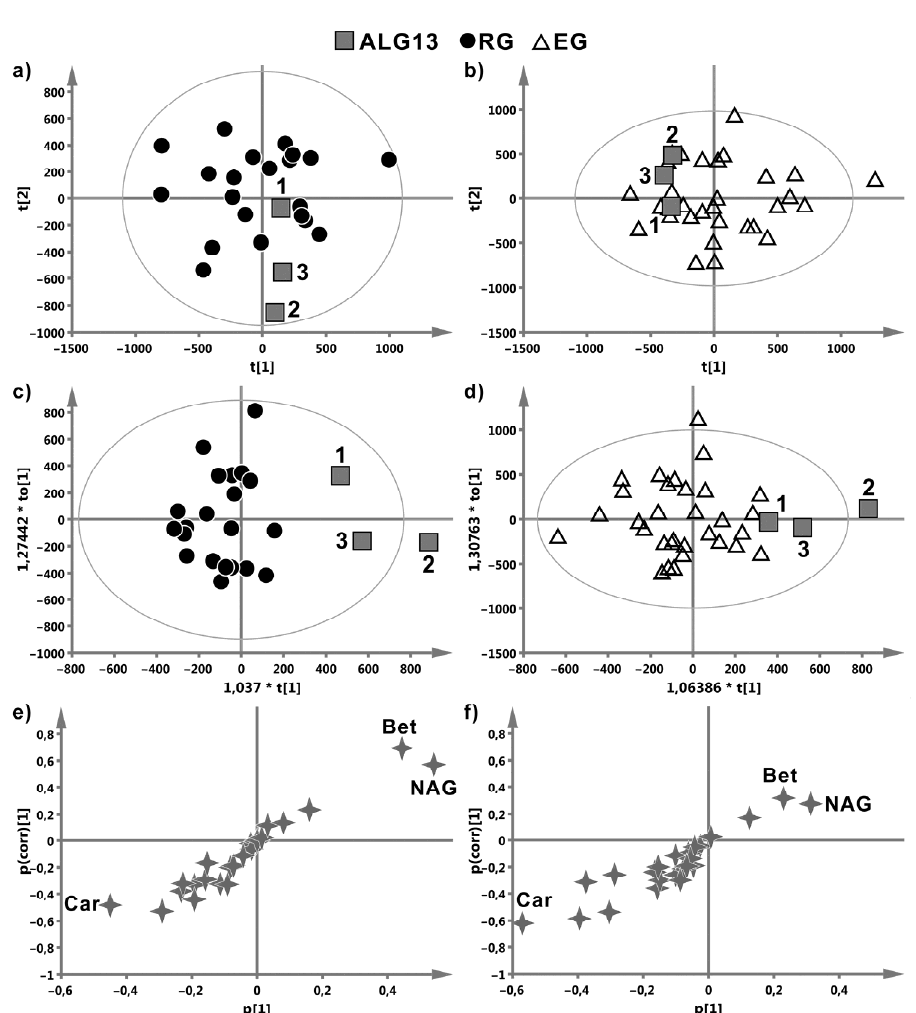
Figure 2. Scores plots from principal component analysis (PCA) ( a , b ) and orthogonal partial least-squares discriminant analysis (OPLS-DA) ( c , d ) distinguishing the ALG13 cases from reference group (RG) ( a , c ) and drug-resistant epilepsy patients group (EG) ( b , d ). The x and y directions in the PCA scores plots ( a , b ) reflect the first two directions of the highest variability in the data. In case of subtle metabolic changes these directions may not necessarily correspond well with the class separation. The x and y directions in the OPLS-DA scores plots ( c , d ) correspond to the inter- and intra-class variability, respectively. The metabolites responsible for the clustering observed in the OPLS-DA scores plots are identified based on the OPLS-DA S-plots ( e , f ). The further the point is from the center of the plot (along both the x and y axis), the more impact this variable exerts on the observed class separation in the scores plot (OPLS-DA only).